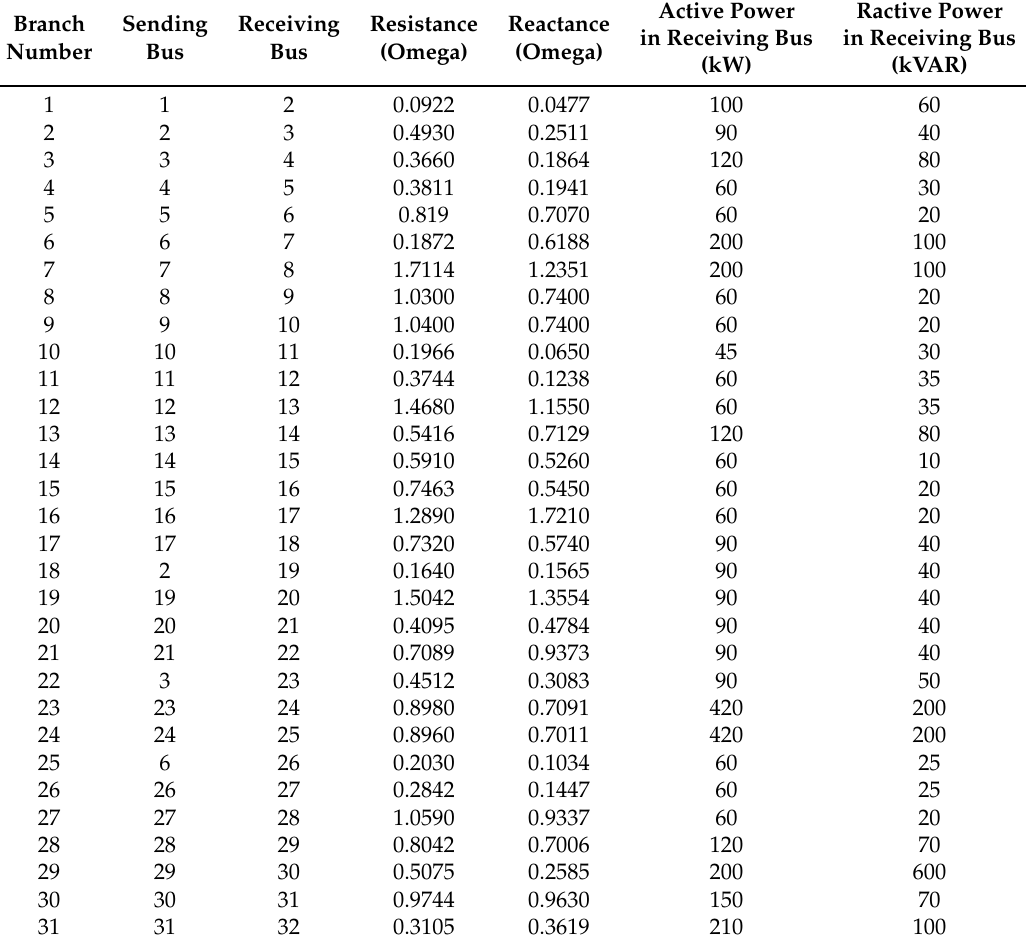
Table A1. Impedance and power of the 33 bus